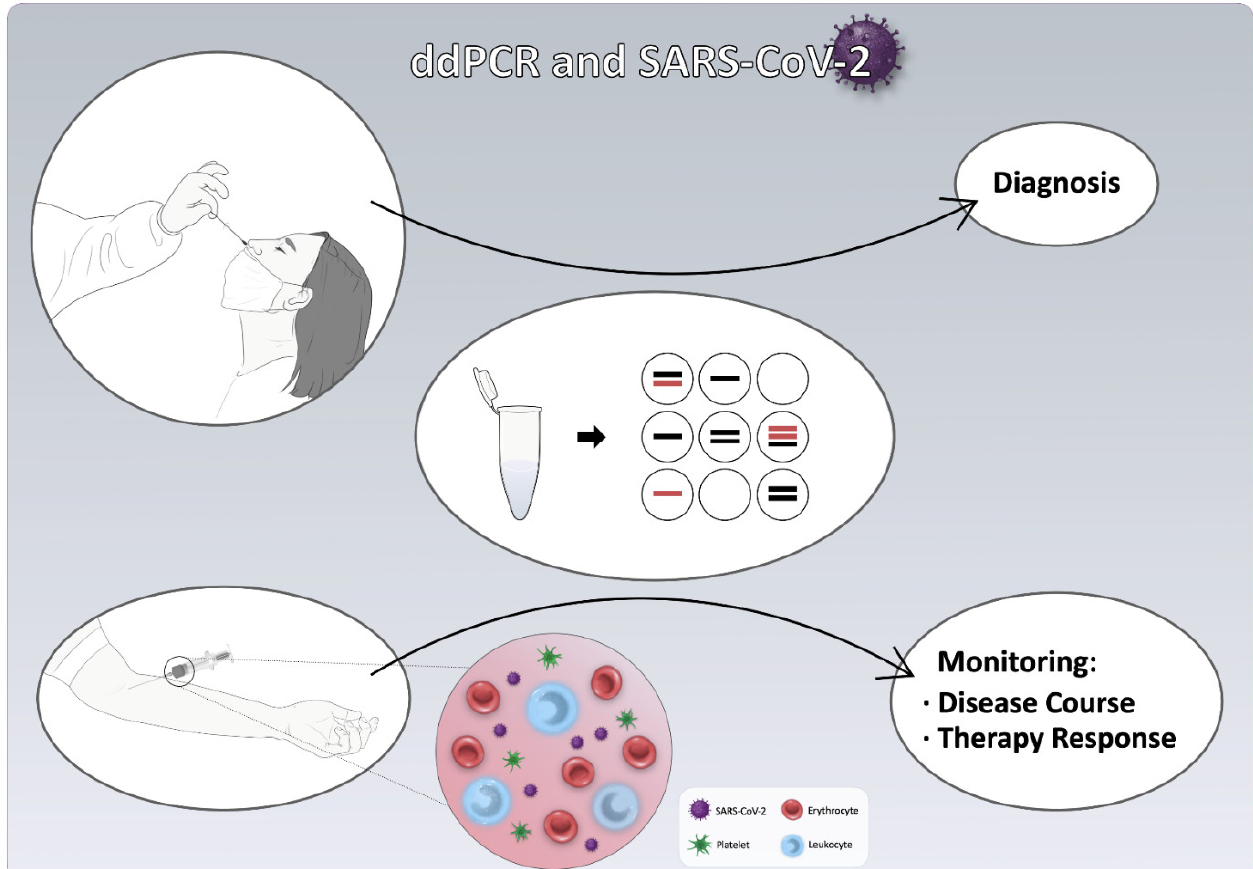
Figure 2. Diagnostic, prognostic, and therapeutic value of droplet digital PCR (ddPCR) in COVID-19 patients.